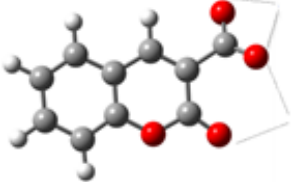
Figure 1. Coordination sites of HCCA.